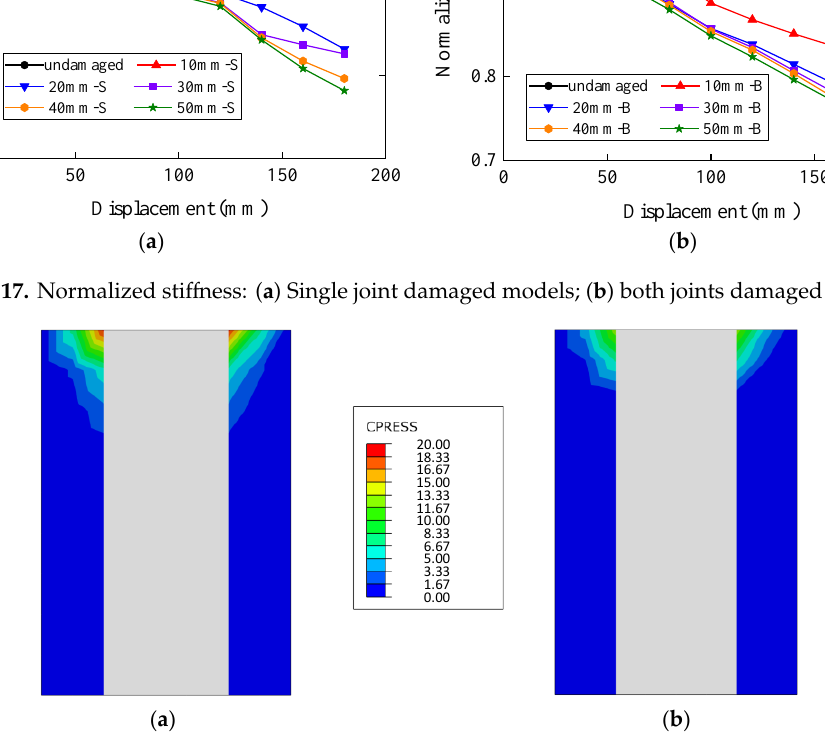
Figure 18. Compressive stress of the vertical surface of the beam when the displacement is +180 mm: ( a ) Undamaged model; ( b ) 10 mm-S model.